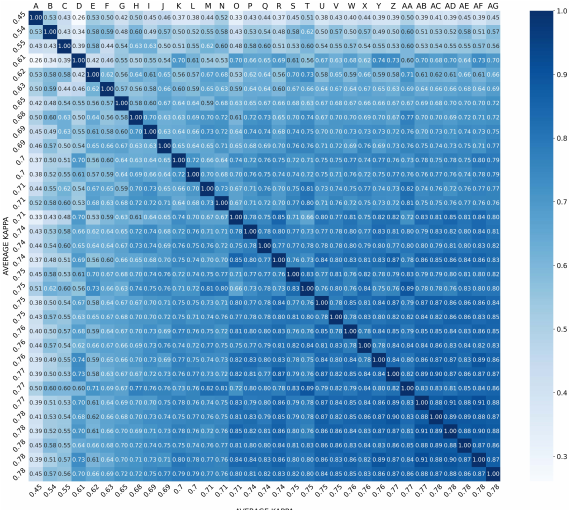
Figure 4. Comparison of the agreement between each pair of raters using Cohen’s kappa. This was obtained from the scores assigned by each rater using all 480 videos. Raters are sorted from left to right based on their overall Cohen’s kappa with their peers (indicated by the axis ticks).